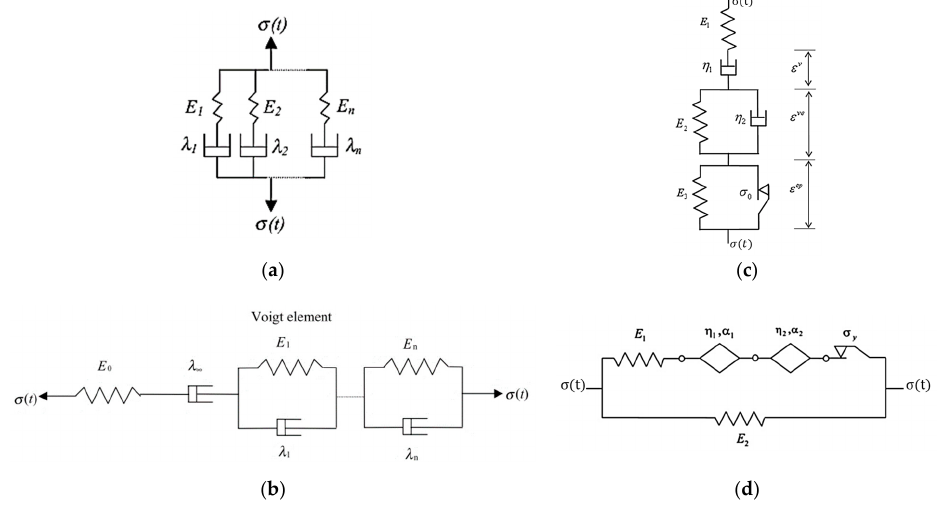
Figure 6. ( a ) Maxwell’s viscoelastic model, ( b ) Burgers viscoelastic model, ( c ) viscoelastic–plastic model with slider, and ( d ) elastic-visco-plastic nonlinear fractional (spring-pot) model.